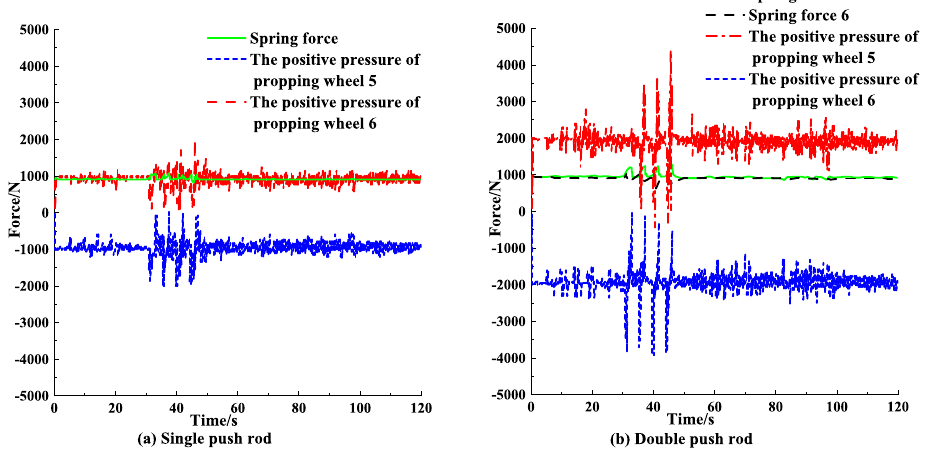
Figure 16. The positive pressure change of propping wheel of single push rod support adjustment mechanism, double push rod − double spring support adjustment mechanism when crossing the well wall deposit and casing wear.